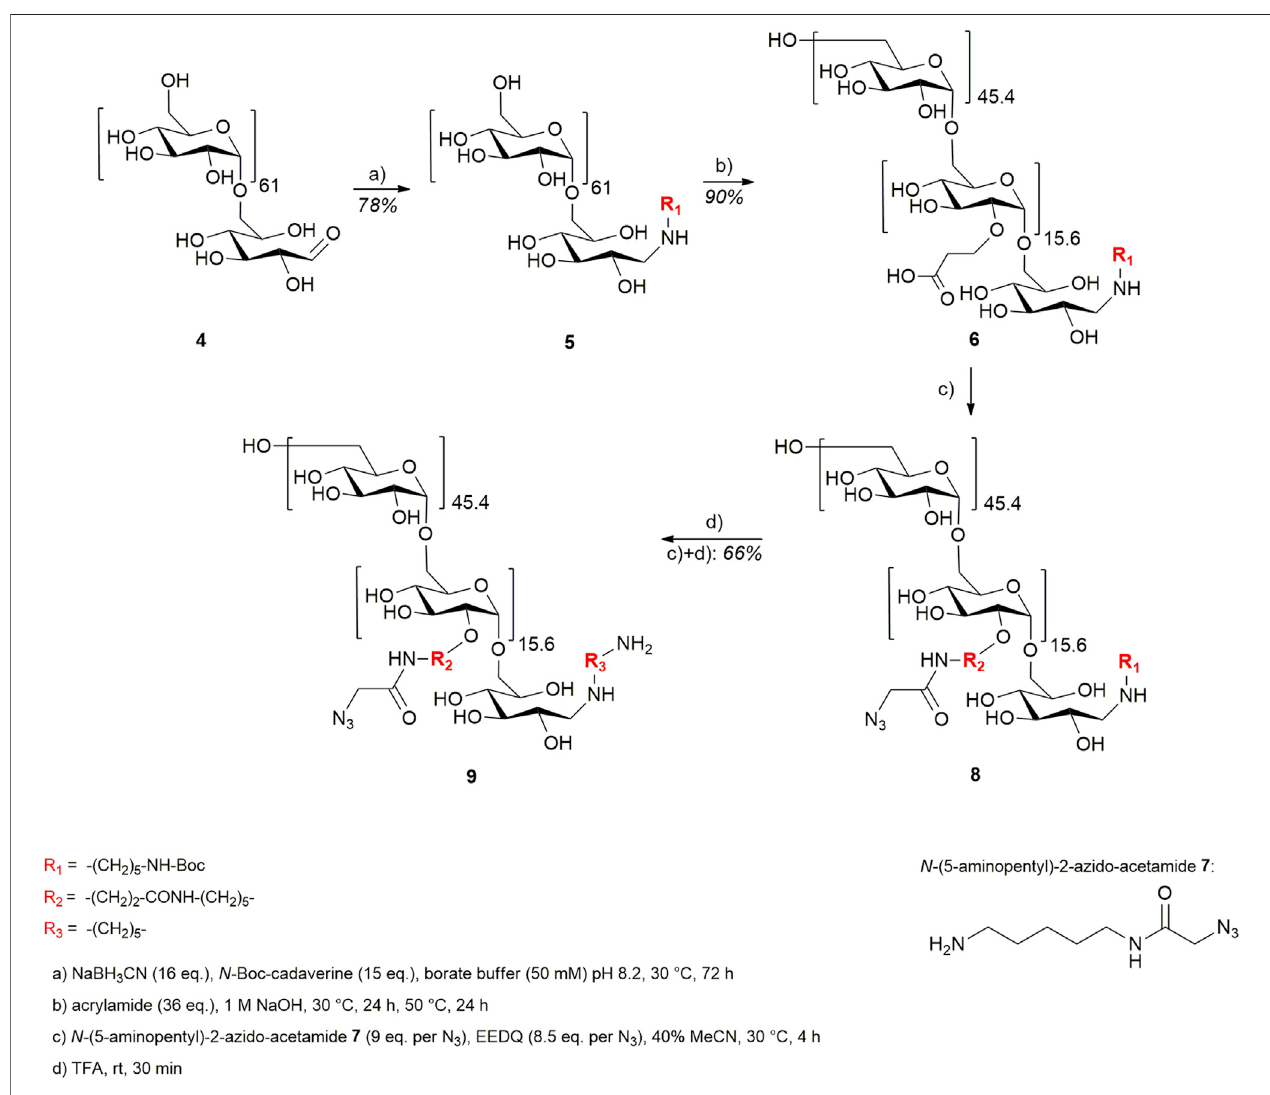
FIGURE 3 | Synthetic approach toward cadaverine – dextran – (N 3 ) 15.6 9 .